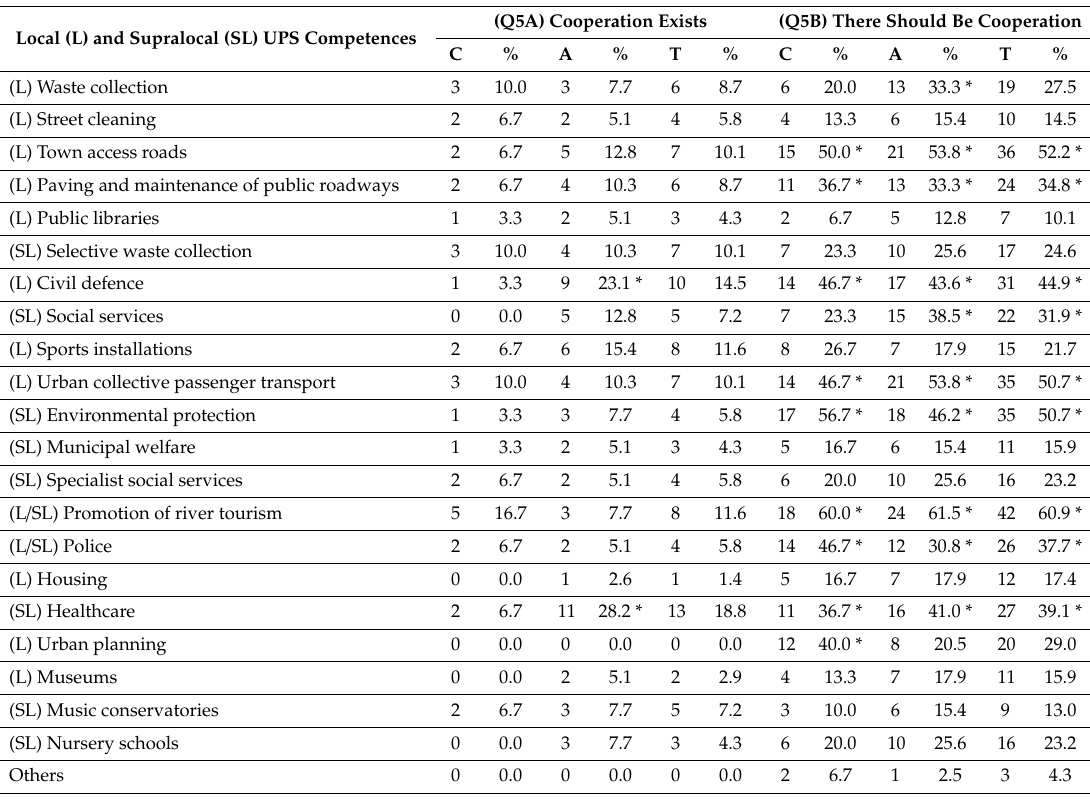
Table 7. Answers obtained in Q5 (source: